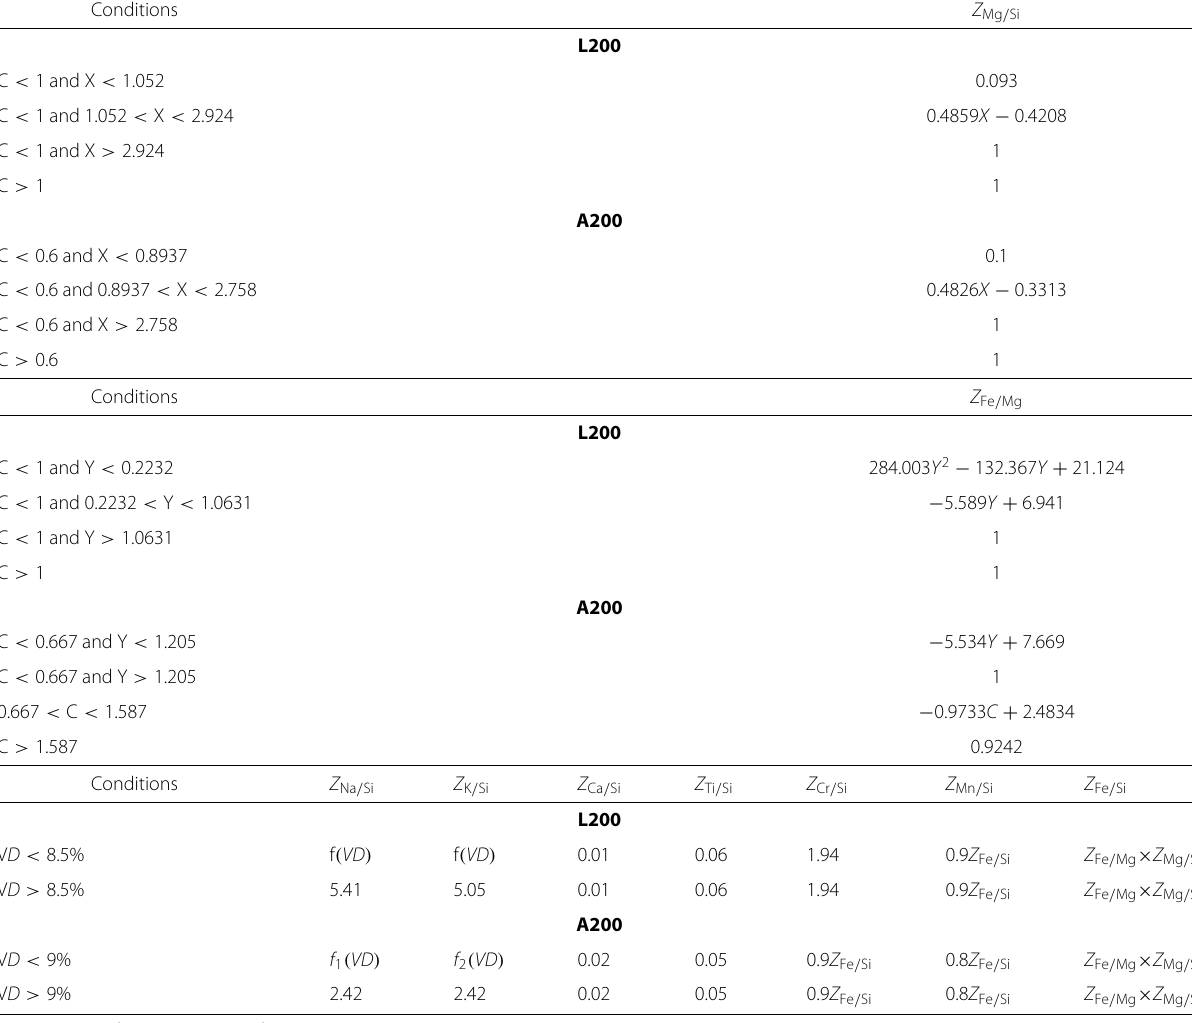
Table 5 The estimated relative volatilities and their applicable